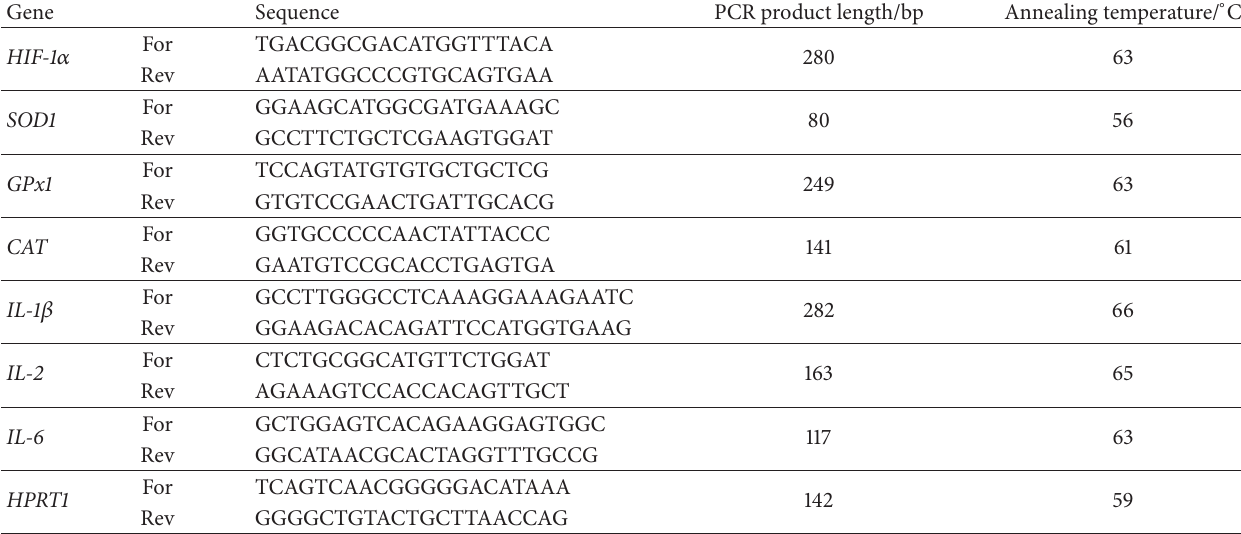
Table 1: Primer sequences, PCR product length, and primers annealing temperature used for qPCR